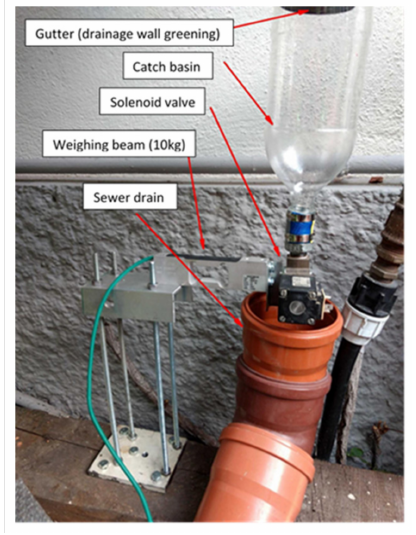
Figure 5. System of discharge